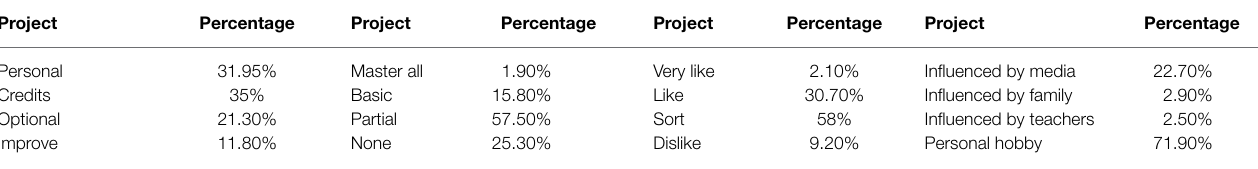
TABLE 4 | Survey of non-music major undergraduates taking music courses in universities.